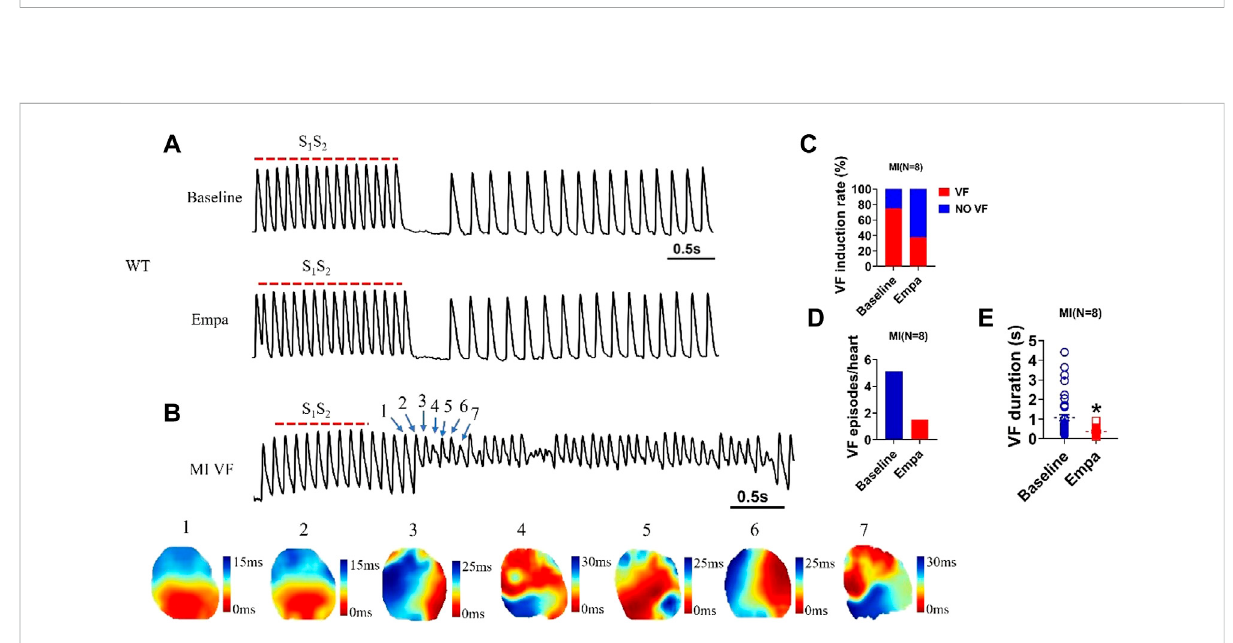
FIGURE 7 EMPA reduced the VF vulnerability in infarcted ventricles. (A) Ventricular fi brillation (VF) induced by S1S2 pacing at baseline and in the presence of EMPA in normal ventricles. N = 5mice. (B) Ventricular fi brillation (VF) and active map by S1S2 pacing at baseline in infarcted ventricles. N = 8 mice. (C – E) VF induction rate and duration at baseline and in the presence of EMPA in infarcted ventricles. N = 8 mice. * p < 0.05 versus baseline. p -values were determined using an unpaired t